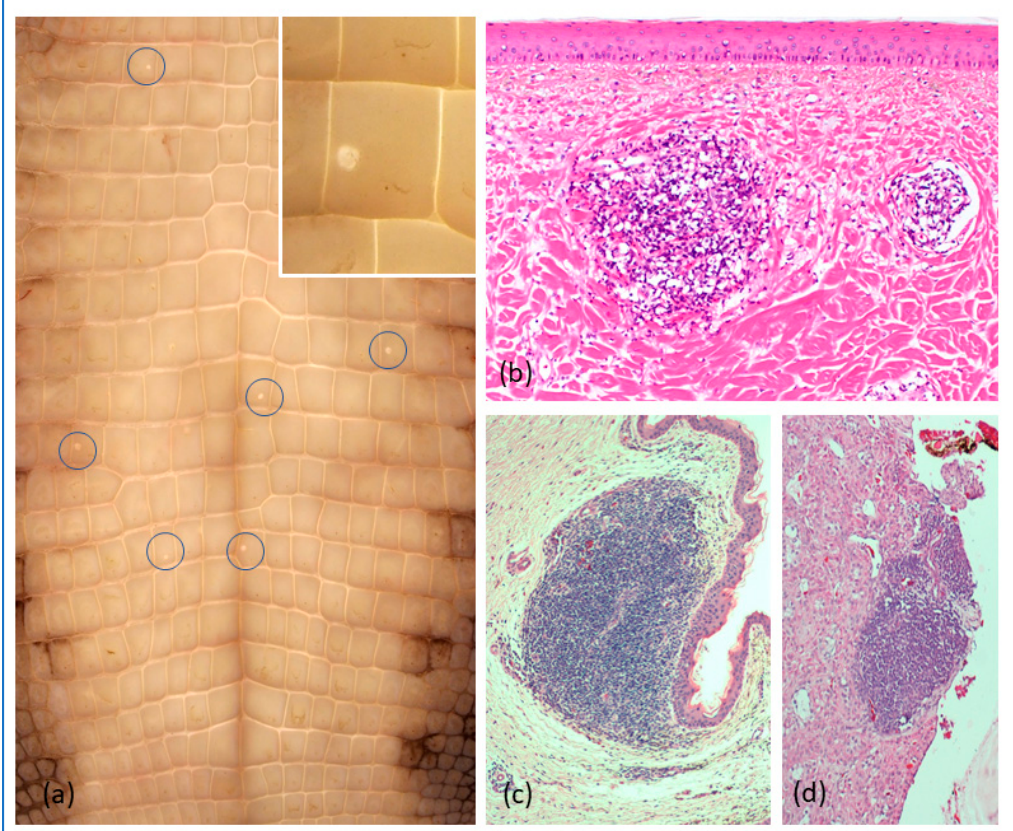
Figure 5. Representative gross and histopathological changes in experimentally WNV-infected C. porosus hatchlings. ( a ) Typical WNV-induced skin lesion (“pix”; enlarged in insert); ( b ) Microscopic appearance of a typical “pix” lesion; ( c ) Lymphofollicular aggregate in subepithelial layers of the oral cavity; ( d ) Lymphofollicular aggregate in the adrenal gland.